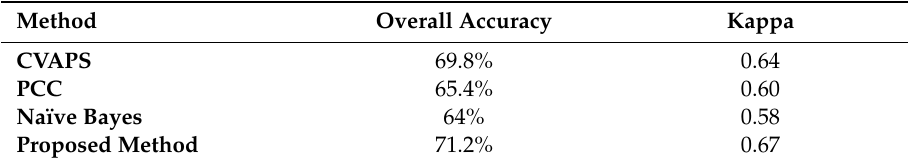
Table 2. Accuracy assessment of LULC type-of-change identification in Experiment